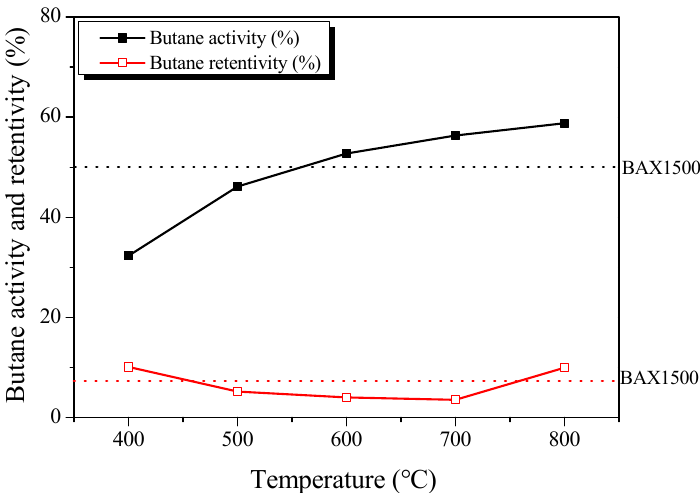
Figure 6. Butane working capacity of kenaf-derived activated carbons as a function of various phosphoric acid activation temperature.